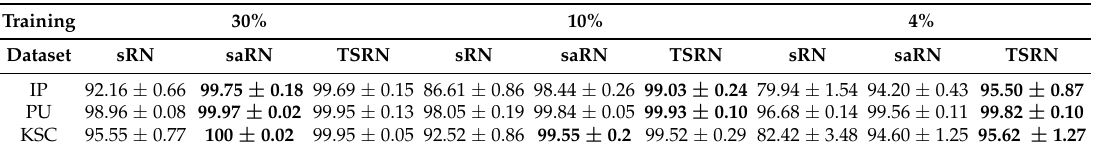
Table 5. Comparison between sRN, saRN, and Proposed (TSRN) with 30%, 10%, and 4% training samples (Bold represents the best results in the experiment